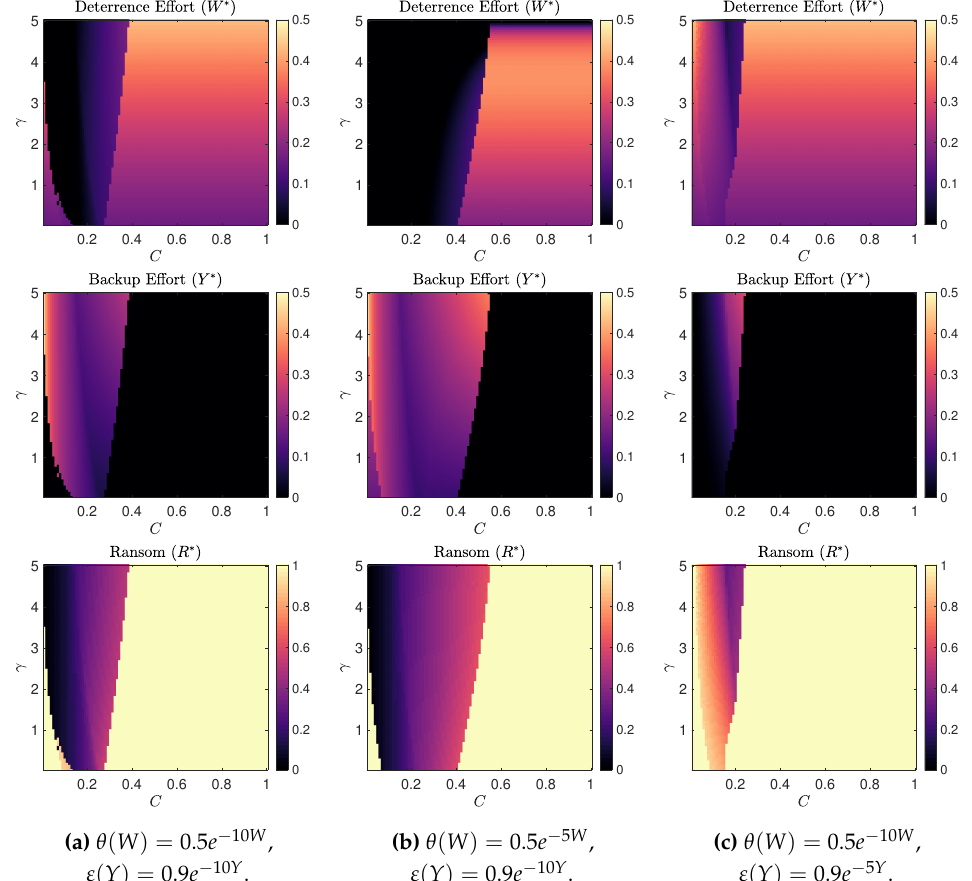
Figure 3. Equilibrium strategies ( W ∗ , Y ∗ , R ∗ ) of the A-D game plotted as a function of C and γ . Unit data value, I = 1, is used in all simulations. Each column employs different or different combinations of θ ( W ) and (cid:101) ( Y ) : the second (resp. third) column has a less effective deterrence (resp. backup) than the first. Regions in each graph are discussed in Section